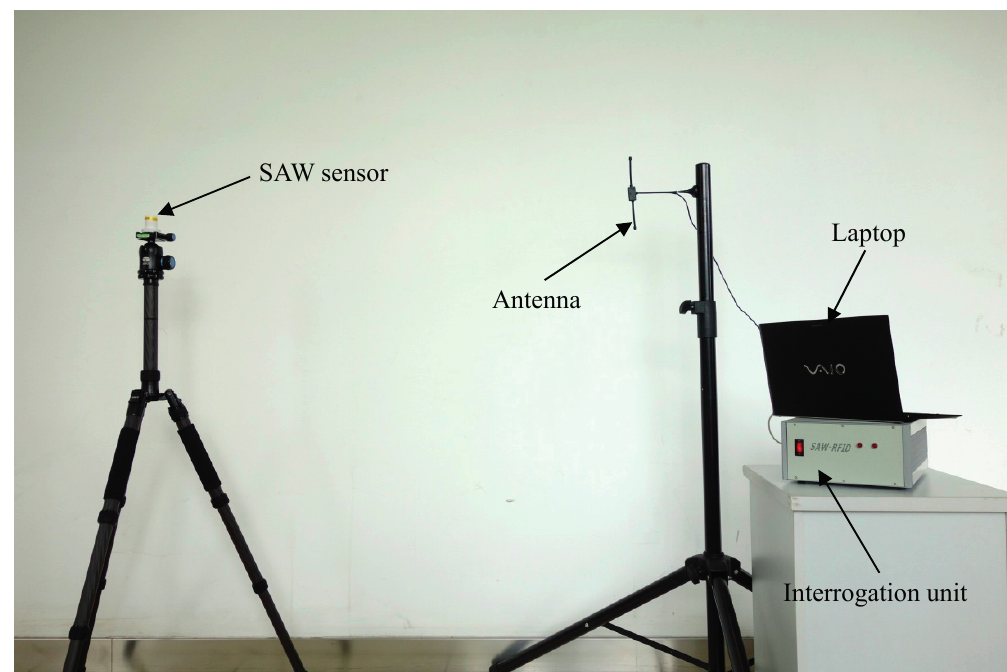
Figure 8. Experimental